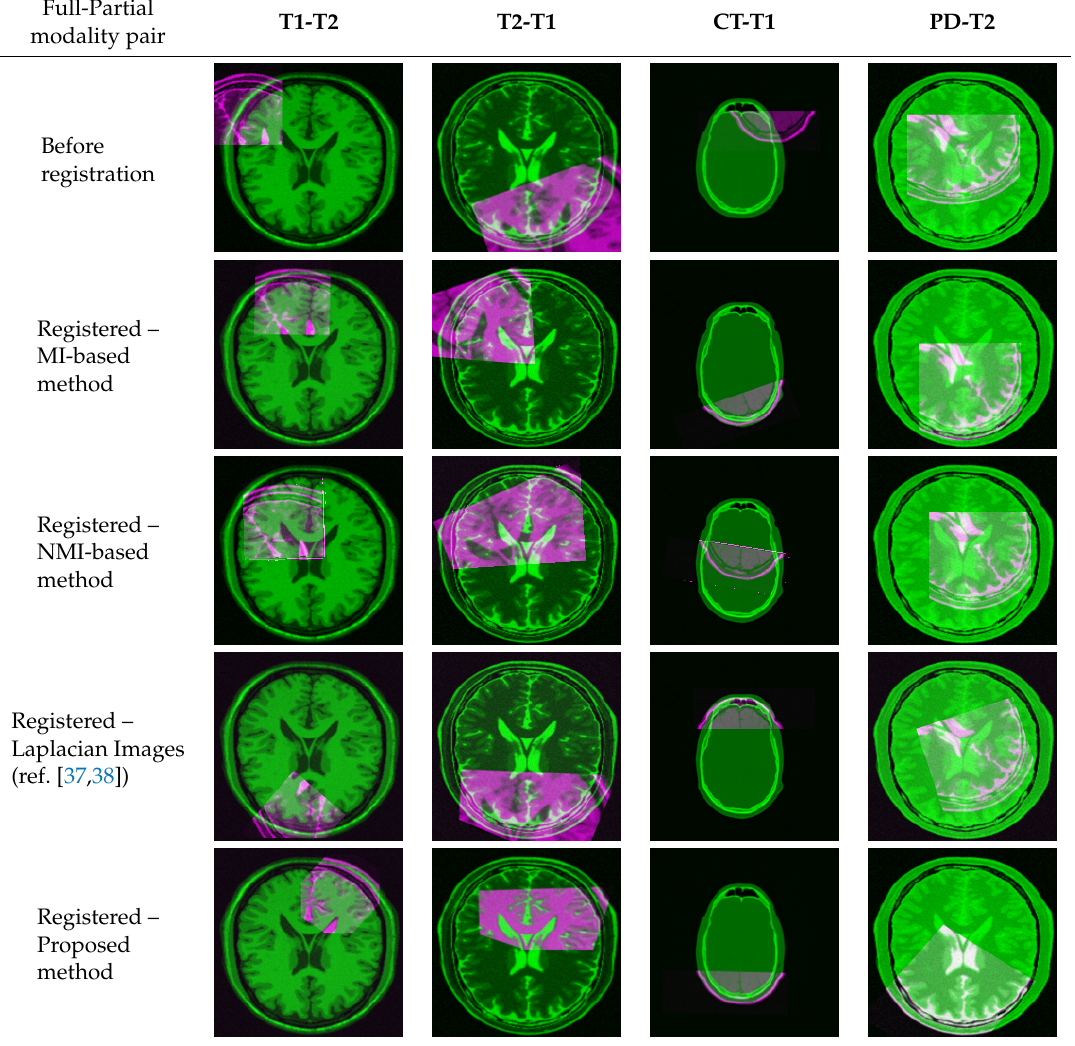
Figure 11. Pairwise display of multi-modal image registration with partial data.